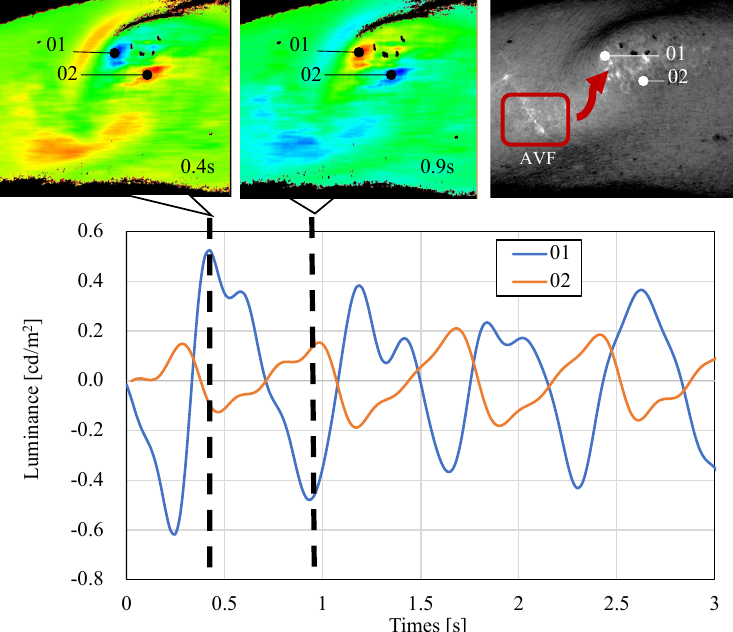
Figure 17. Detailed demonstration of the reversed-phase AVF pulse waveform. The luminance of the (01) measurement point at 0.4s increased, whereas that of the (02) point decreased. On the other hand, at 0.9s, the luminance of the (02) point increased, and that of the (01) point inversely decreased. It was suggested that the shadows caused by the masses may have an effect on the phenomenon of the reversed-phase AVF pulse waveform.